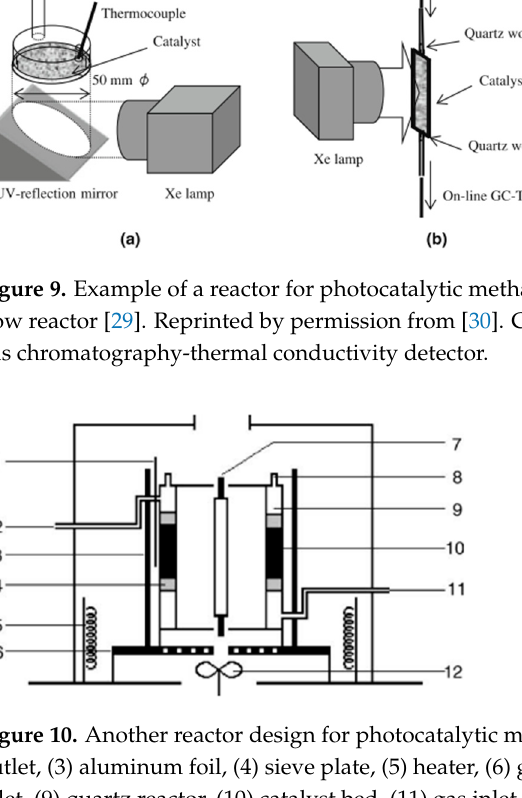
Figure 11. Monolith reactor used in photocatalytic methane reforming. Light can be irradiated deep into the reactor [31]. Reprinted from [32], with permission from Elsevier. FID: flame ioniza- tion detector, MFC: mass flow controller. Figure 12. Example of a reactor for photocatalytic methane reforming. The heater and thermocou- ple are equipped and the surface temperature is also measured [22]. 4. Photocatalytic Steam Reforming of Methane 4.1. Overview of the Reaction SRM is a favorable reaction for producing H 2 because H 2 can be produced from both methane and water. The amount of hydrogen produced per methane is higher than that produced by the other methane-reforming reactions. The disadvantage is that the reaction